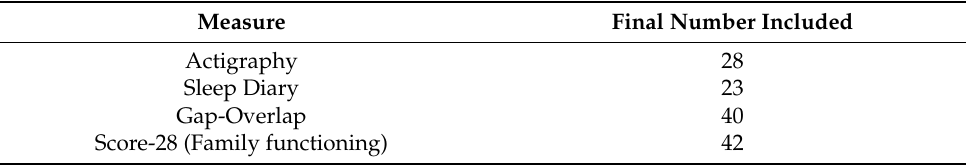
Table 1. Number of participants included in the